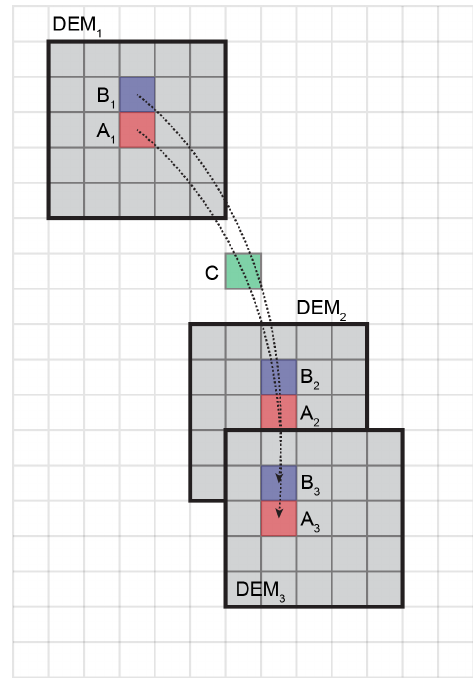
Figure 7. Illustration of Lagrangian D h/ D t calculation and basal melt-rate distribution on a Eulerian grid (light gray). Three DEMs (medium gray) acquired at times t 1 , t 2 , and t 3 are resampled on this grid, with the same “features” A and B indicated as colored pixels. The position history for “particle” A is estimated using the velocity products described in Sect. 2.5, with paths indicated by dotted